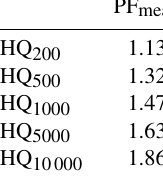
Table 2. Statistical peak factors (PFs) for the LUBW data set. The statistical peak factor is defined as HQ X ( X = 200, 500, 1000, 5000, 10000) divided by HQ 100 , separately for each gauge in the data set. PF mean is the mean peak factor of all 355 gauges, and PF max is the largest factor. PF mean